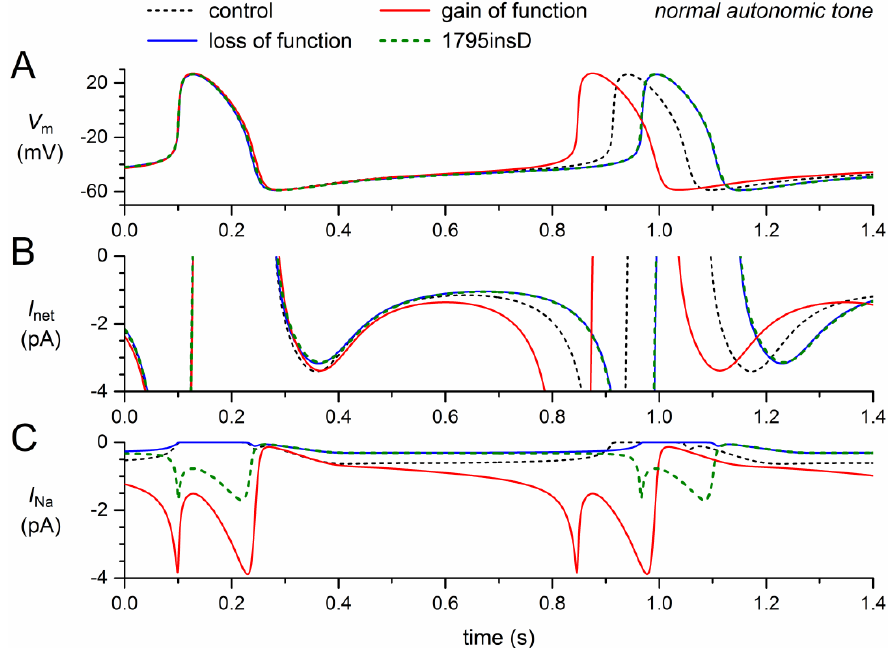
Figure 4. Changes in the electrical activity of the Fabbri – Severi model cell at normal beating rate (normal autonomic tone) due to loss-of-function (reduced g Na and shifts in the steady-state activation and inactivation curves) and gain-of-function ( I pst ) effects as observed for the 1795insD mutation in SCN5A . ( A ) Membrane potential ( V m ). ( B ) Net membrane current ( I net ). ( C ) Fast sodium current ( I Na ). Effect of the loss-of-function effects per se (blue traces), the gain-of-function effects per se (red traces), and the combined effect (dashed green traces). In the model, I Na is split into a wild-type and a mutant component, thus representing the effect of a heterozygous mutation.